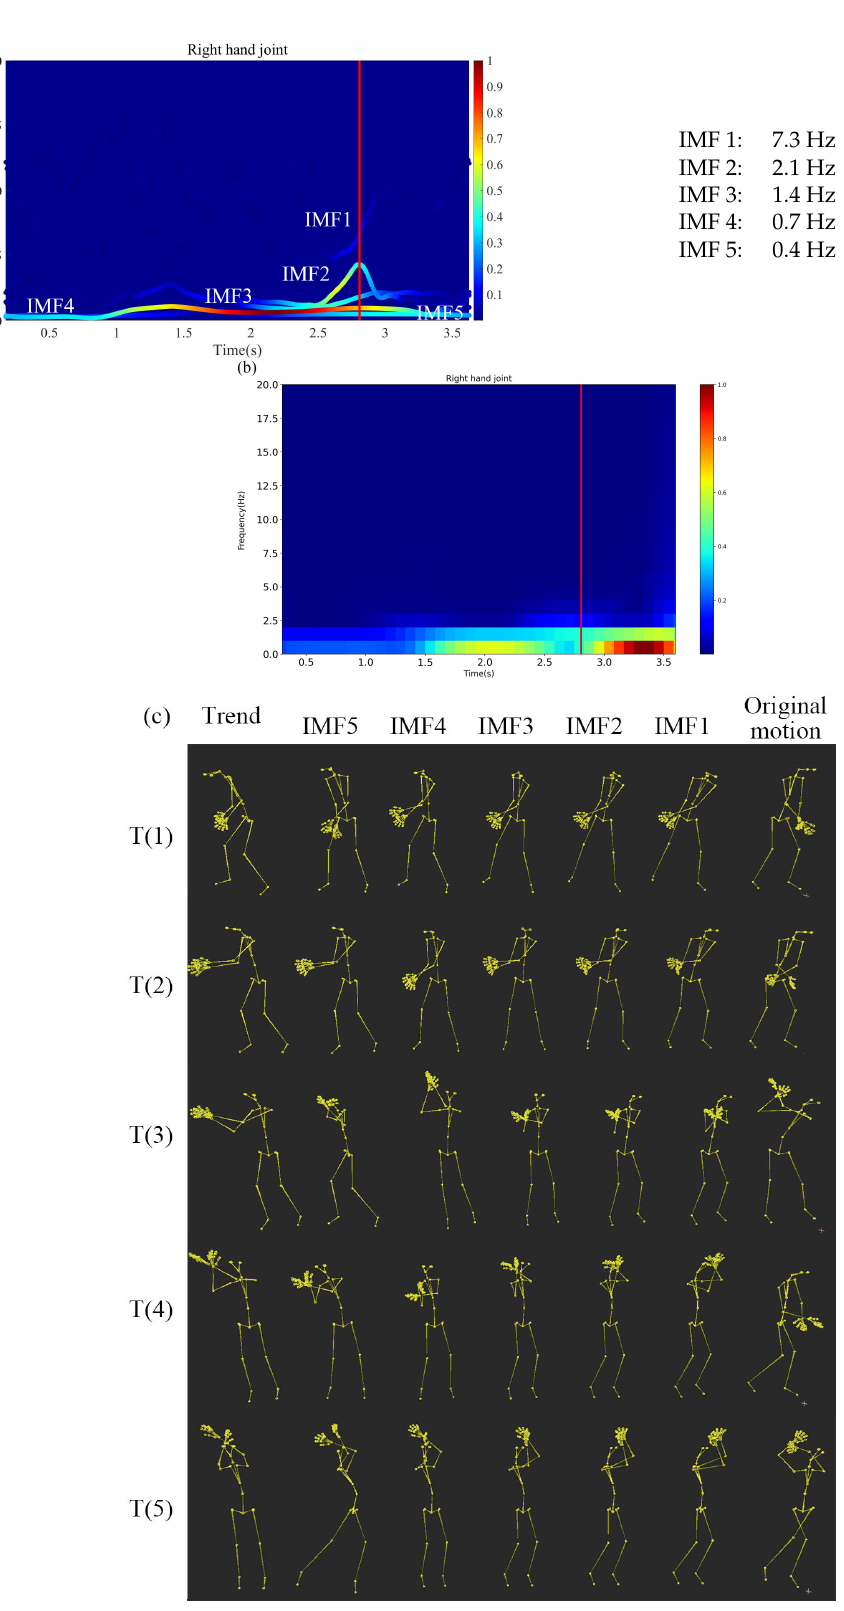
Figure 8. Decomposed golf swing motions using our proposed framework. ( a ) The spectrum of right hand joint. ( b ) STFT (Short Time Fourier Transform) spectrum of the right hand joint. ( c ) Each of the IMFs and the trend motions decomposed by MEMD. Here, T(1)–T(5) correspond to the time 0.3 s, 1.1 s, 1.9 s, 2.7 s, and 3.5